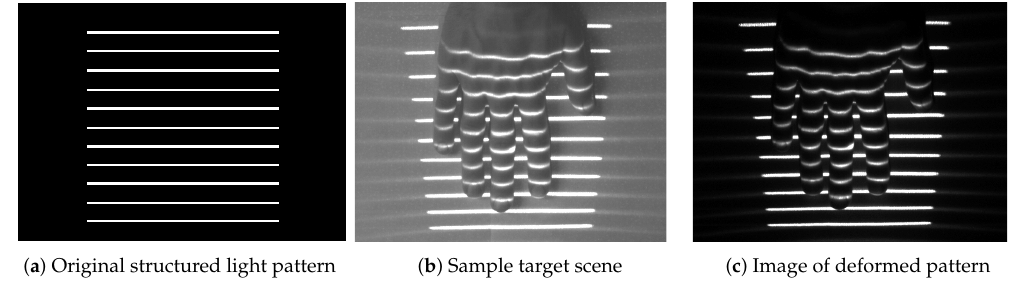
Figure 3. The correspondence problem: ( a ) an illustrative image of the structured light pattern produced by the ATRIS sensor, without distortions; ( b ) an example of a target scene illuminated by the light pattern; ( c ) an example of the spatial distortion map captured with the sensor. To be able to reconstruct a depth image of the target scene, each pixel comprising the light pattern in ( c ) needs to be assigned a label corresponding to one of the light planes in the pattern shown in ( a ).